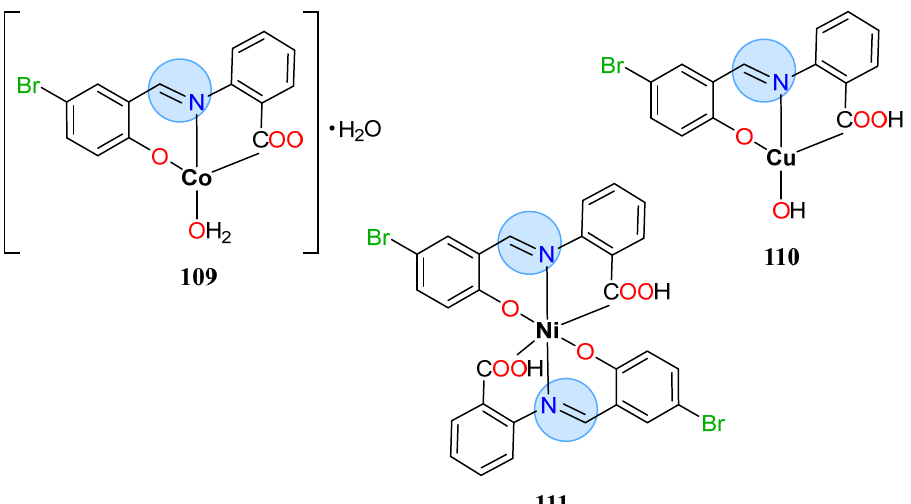
Figure 57. Metal(II) complexes with a Schiff base ligand (ONO) derived from anthranilic acid and 5-bromosalicylaldehyde.